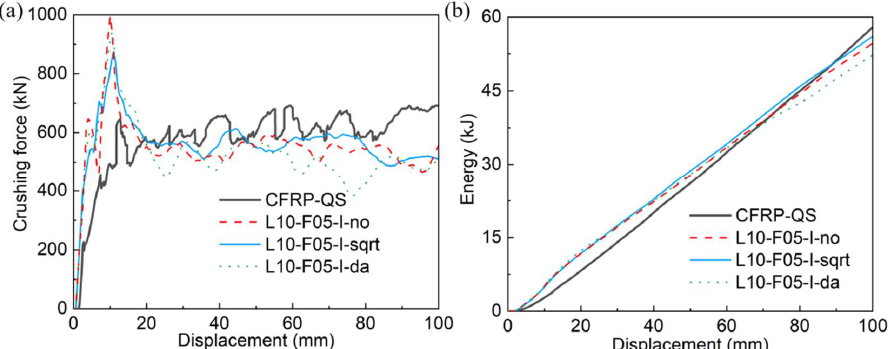
Figure 12. Comparisons of ( a ) crushing force–displacement curves and ( b ) energy–displacement curves between experimental (CFRP-QS) and simulated results using three pairs of inter-layer fracture energy values.